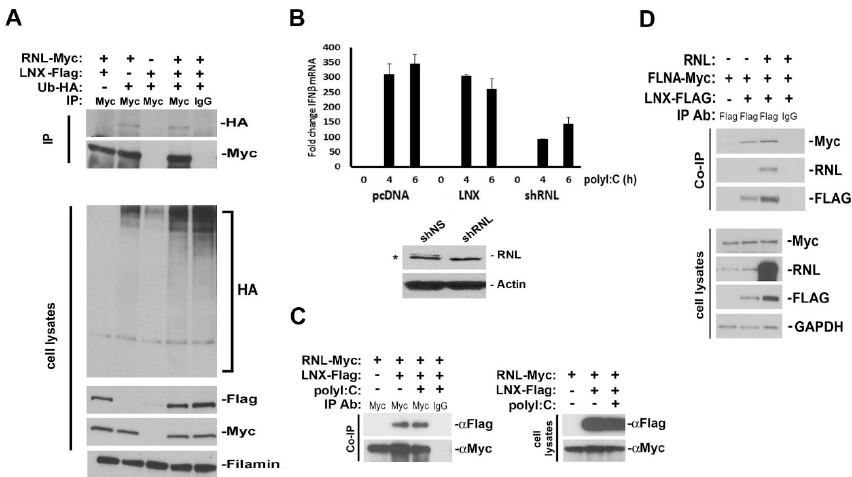
Figure 3. Characterization and consequences of LNX expression. ( A ) Ubiquitylation of RNase-L is not enhanced by LNX expression. 293T cells were transfected with LNX, RNase-L, and HA-tagged ubiquitin (Ub). The presence of Ub-HA-conjugated RNase-L was determined by Western blot; ( B ) Hela cells were transfected with the indicated vectors. After 48 h, cells were transfected with polyI:C for 4 and 6 h and then analyzed by RT-qPCR for IFN β expression, relative to rpl13a mRNA. Error bars represent standard deviation of two experiments. Western blot demonstrates shRNA knockdown of RNase-L expression. * indicates a non-specific band ( C ) 293T cells were transfected with LNX and RNase-L. After 48 h, cells were transfected with polyI:C for 6 h and then interaction was analyzed by IP; ( D ) Analysis of FLNA-myc and LNX-Flag interaction. FLNA and LNX were transfected into 293T cells in the presence or absence of RNase-L. Cell lysates were immunoprecipitated for LNX-Flag and Western blots probed for FLNA interaction. The presence of exogenous RNase-L did not alter the